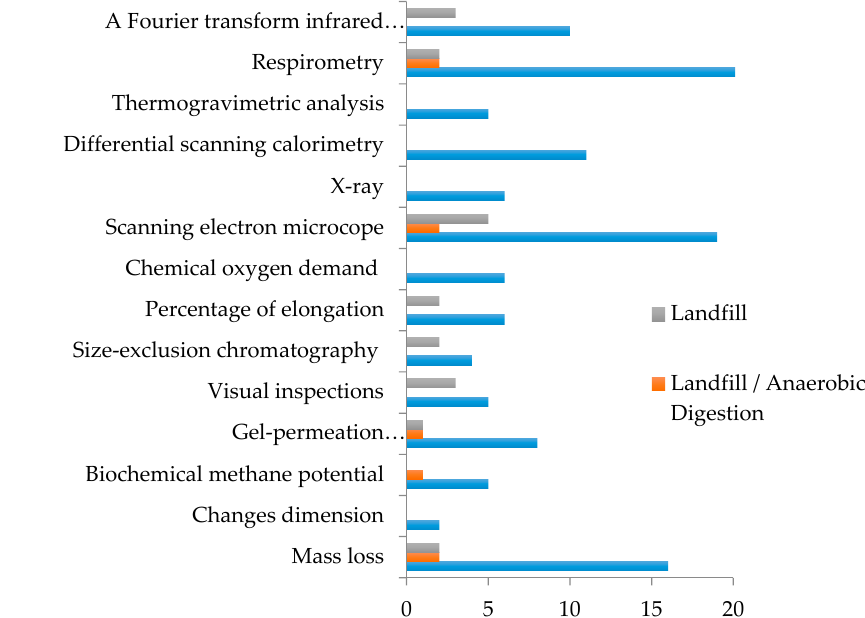
Figure 3. Frequency of methods used to assess plastic degradation and biodegradation.